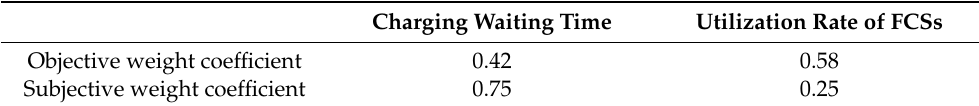
Table 9. Combined weighting coefficient of